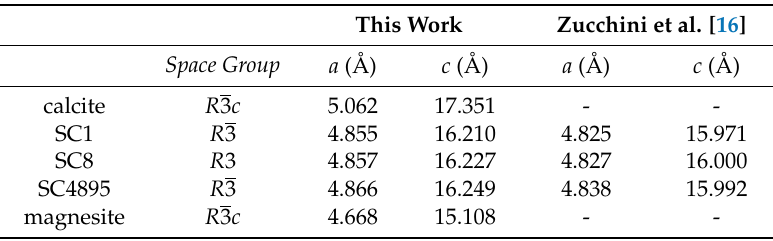
Table 1. Optimized hexagonal cell parameters (Å) of calcite, magnesite and dolomite (SC1, SC8 and